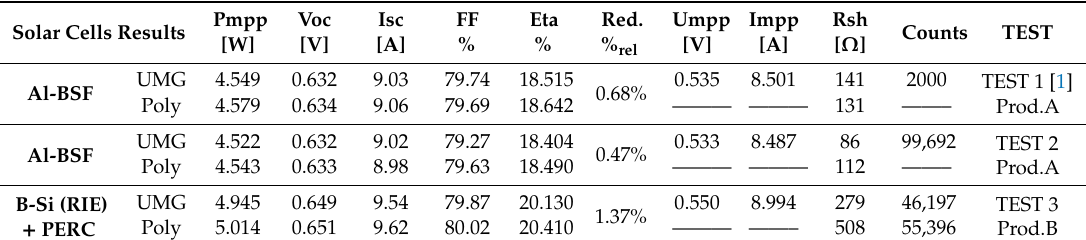
Table 2. Average values of solar cells production. Comparison between polysilicon and UMG-Si. The dashes in the cells stand for data not given by the producer. Column Red.% rel refers to relative reduction in e ffi ciency between UMG and